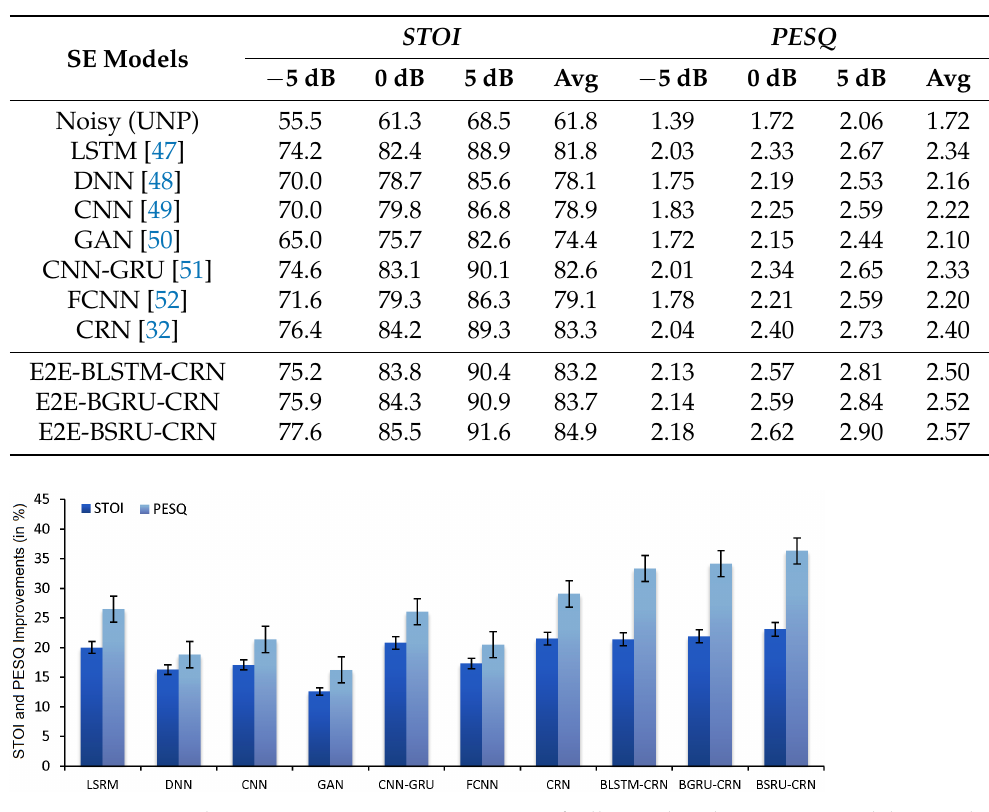
Table 6. Comparison with other SE Models.